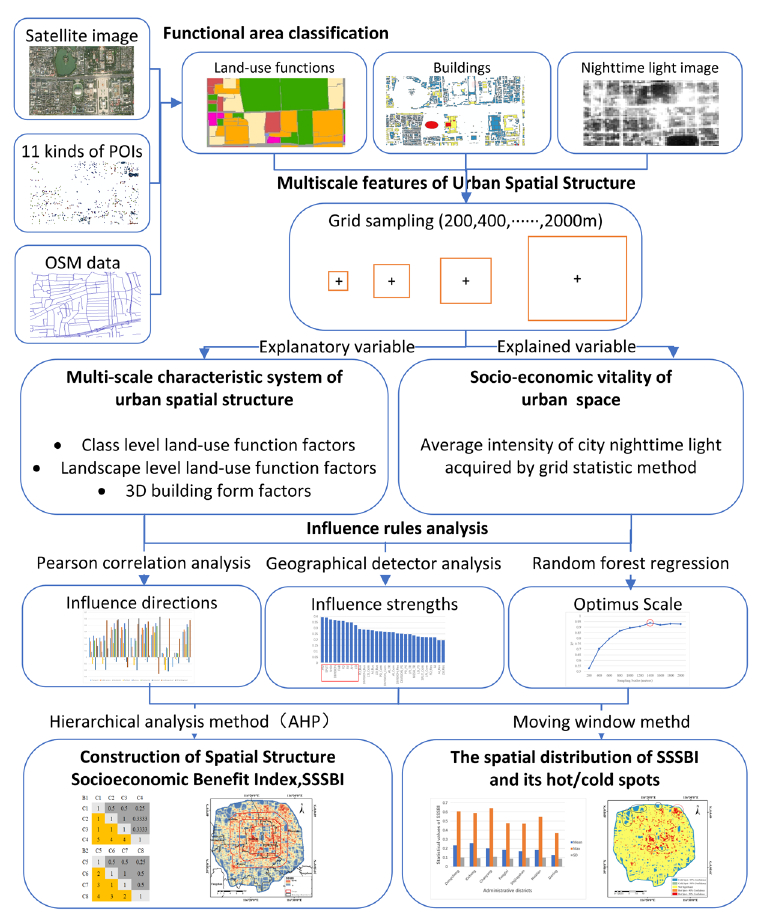
Figure 3. Flowchart of this study.